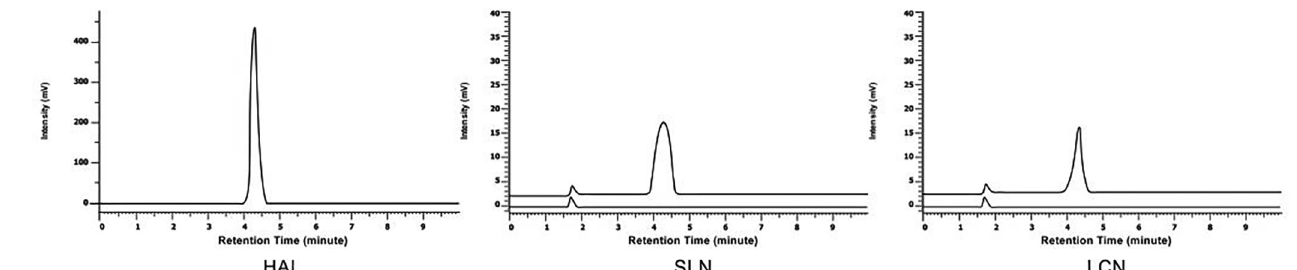
FIGURE 2 - Representative HPLC chromatograms obtained from halcinonide standard solution (25.0 μg.mL -1 ) in methanol:water and halcinonide-loaded and unloaded nanoparticles: LCN and SLN. Mobile phase: methanol:water (85:15 v/v); flow rate: 1.0 mL/min; detection wavelength: 239 nm; column temperature: 25±2 °C; and injection volume: 20 µL. HAL: halcinonide. Retention time: 4.21 minutes.